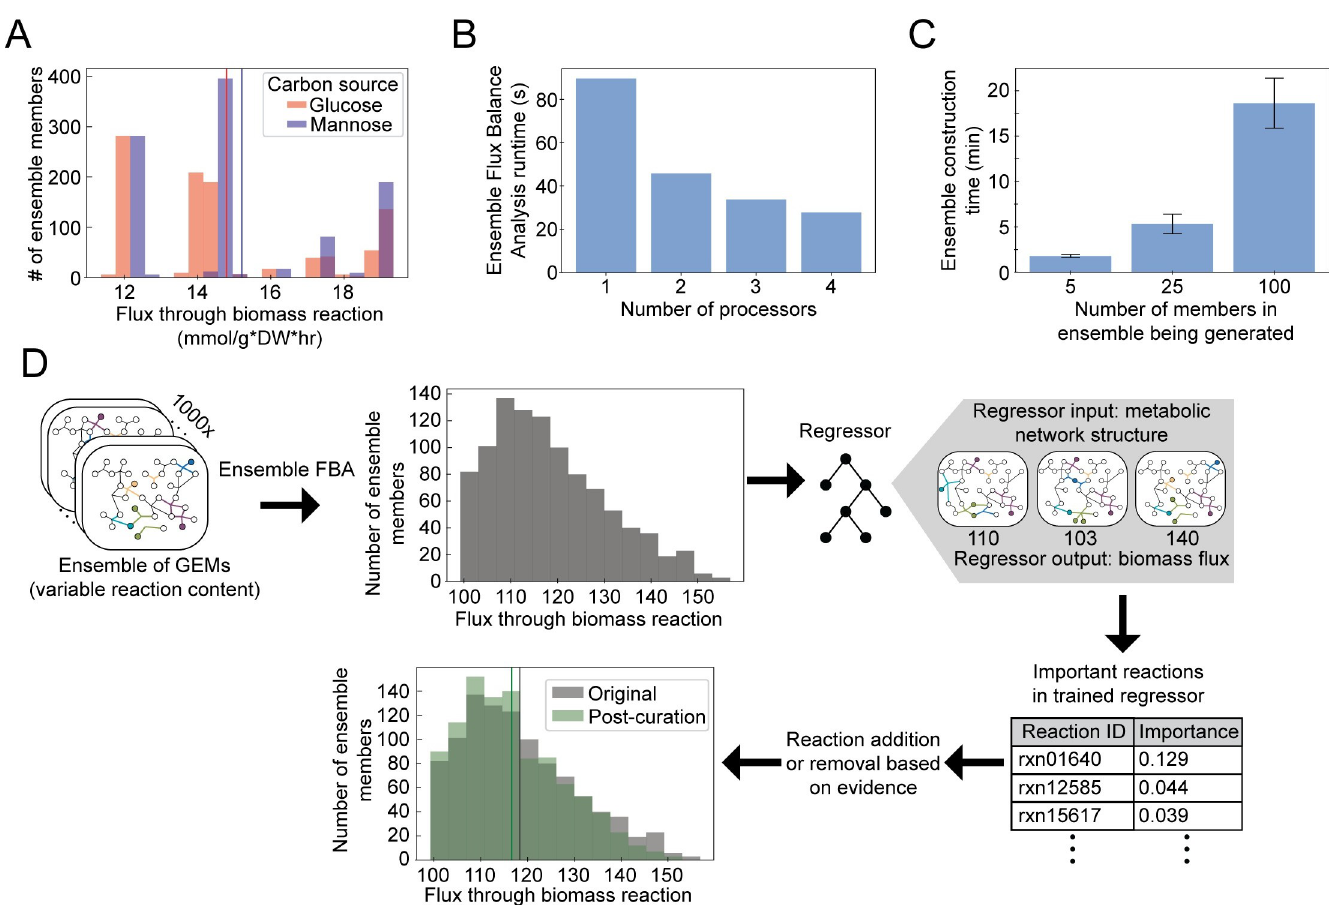
Fig 2. Usage and benchmarking of Medusa. A) Comparison of ensemble flux balance analysis (FBA) simulations across different conditions . A) Ensemble FBA performed on glucose or mannose minimal media using an ensemble of 1000 GEMs for Staphylococcus aureus . This ensemble was generated in [6] by iteratively gap- filling a draft reconstruction to enable biomass production in single-carbon source growth conditions supported with experimental data. Mean for the distribution for either condition shown by vertical line of same color. Predicted flux through biomass is higher on mannose than glucose (Wilcoxon signed-rank test, p < 1E-5). B) Benchmarking of Ensemble FBA. Simulations were performed with the same S . aureus ensemble of 1000 members as in panel A. C) Benchmarking of ensemble generation time with iterative gapfilling (process shown in Fig 3). D Comparison of Ensemble FBA simulations before and after curation using a machine learning- guided approach. Ensemble FBA was performed on complete medium (uptake of -1000 mmol/g � DW � hr allowed for all metabolites) using an ensemble of 1000 GEMs for S . aureus . Mean for the distributions before and after curation shown by vertical line of same color in the last panel in the workflow. Ensemble and machine- learning guided curation identified N-Formimino-L-glutamate iminohydrolase as a driver of variation in simulated flux through biomass. Based on a literature search, this reaction was inactivated in all ensemble members and ensemble FBA was performed again, resulting in the shift in the distribution shown. See documentation for full narrative-style example: https://medusa.readthedocs.io/en/latest/machine_learning.html.